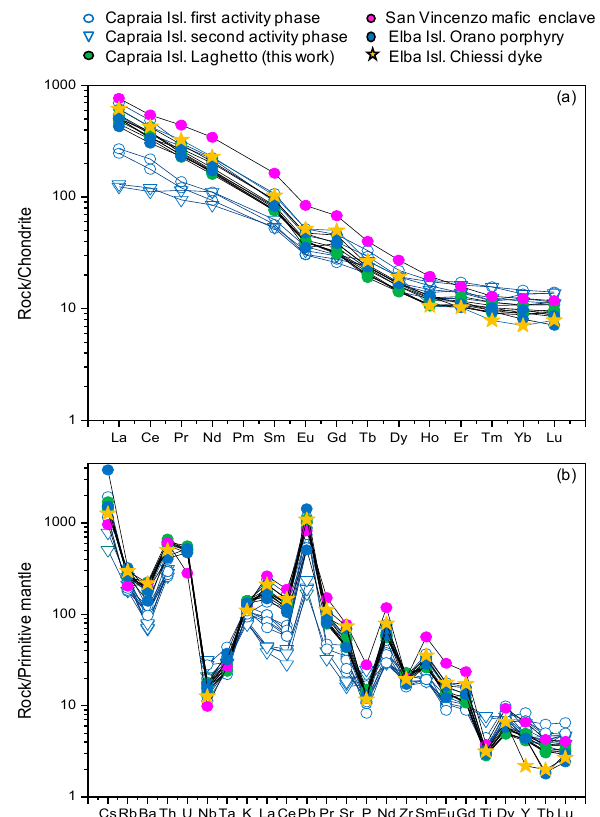
Figure 8. ( a ) Chondrite normalised REE patterns and ( b ) Primitive mantle normalised trace element patterns for the Laghetto rocks. Patterns of other Capraia rocks [9,28], Elba dykes [15,35] and a San Vincenzo mafic enclave [16] are shown for comparison. Normalising values from Sun and McDonough [36]. Sr-Nd isotope ratios of the analysed samples fall in the range of 87 Sr/ 86 Sr = 0.709553– 0.710009 and 143 Nd/ 144 Nd = 0.512331–0.512343. Sr-isotope ratios overlapped or were some- what higher than other Capraia rocks reported in the literature [9,28]. Overall, the Capraia rocks, as well as the Elba dykes and San Vincenzo enclaves, plot near to the lowest Sr and highest Nd isotope distribution range of the Tuscany Province, whose main isotopic char- acteristic is the intermediate composition between typically mantle-derived and crustal anatectic magmas (Figure 9). The few published Pb isotope ratios show poorly radiogenic values, as typically found in other rocks from the Tuscany Province ( 206 Pb/ 204 Pb = 18.65– 18.73; 207 Pb/ 204 Pb = 15.64–15.70; 208 Pb/ 204 Pb = 38.96–39.09; [9] and references therein).